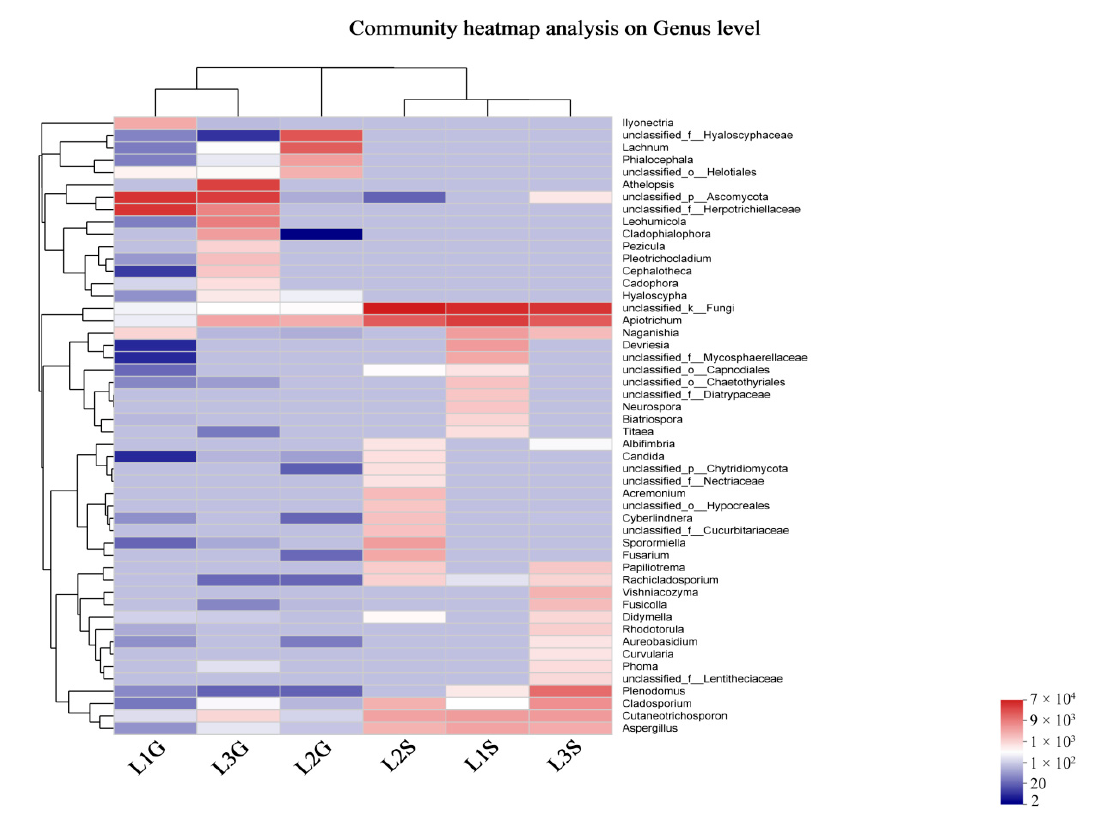
Figure 4. Heat maps of the relative abundance of culture-independent endophytic fungi in S. chamaejasme at genus level, based on an analysis of the first 50 most abundant genera. Different color indicates difference in relative abundance (Log10) of the taxa in the samples (red means high relative abundance).